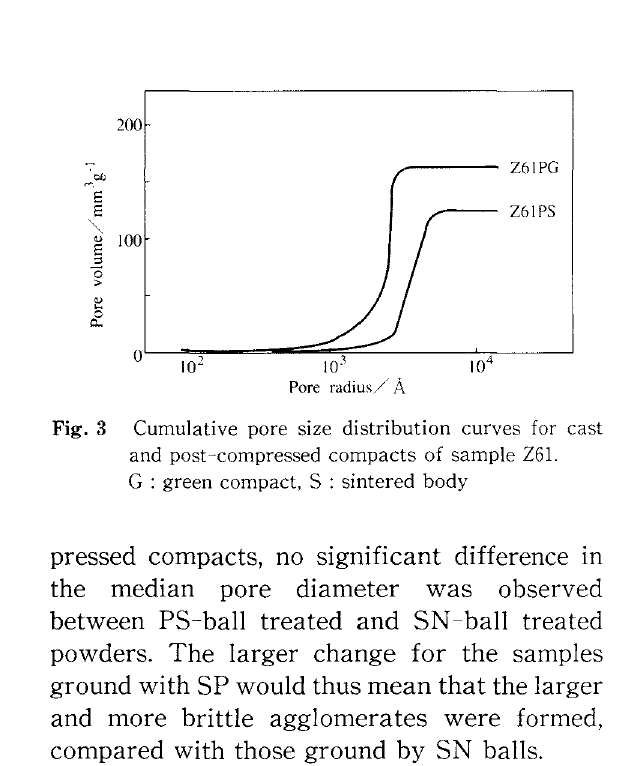
Cumulative pore size distribution curves for cast and post-compressed compacts of sample